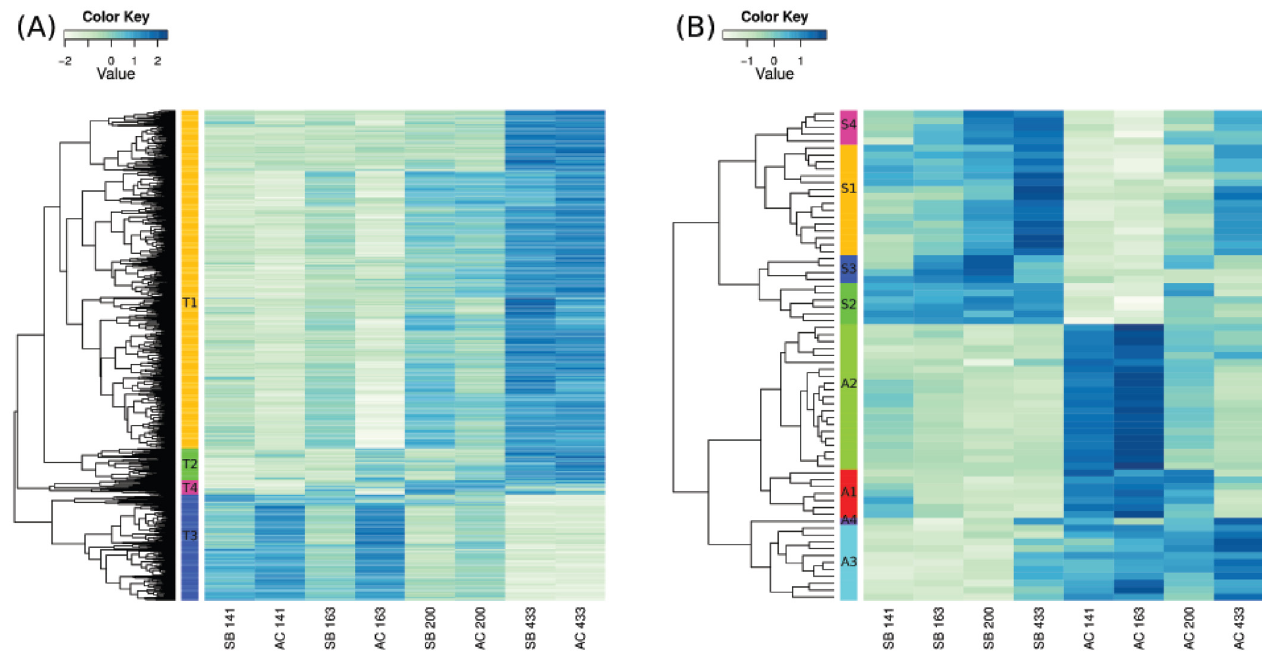
Figure 3. Heatmap of differentially expressed genes in the Arctic charr developmental transcriptome. Two morphs (SB and AC) are represented, at four timepoints. ( A ) The 1603 genes with expression difference among time points, here clustered into four groups. ( B ) The 71 genes differentially expressed between morphs are clustered into 4 groups for each morph. High expression is indicated by blue and low expression by